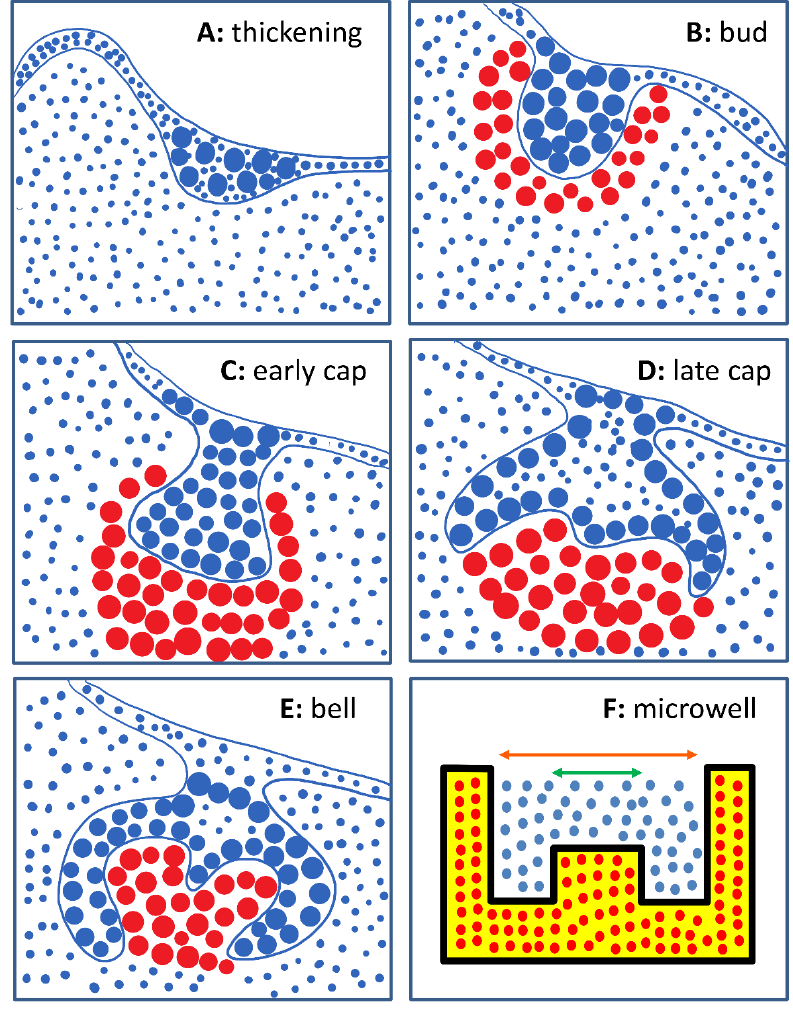
Figure 1. Human tooth development process and schematic representation of a tooth. ( A ) Thickening stage: Proliferation and thickening of oral epithelium; ( B ) Bud stage: Invagination of oral epithelium into mesenchyme and formation of tooth bud; ( C , D ) Cap stage: Condensation of mesenchyme around tooth bud, folding and formation of tooth germ; ( E ) Bell stage: Further folding to form tooth crown, differentiation into ameloblasts and odontoblasts. ( F ) Cross-sectional diagram of a single microwell. Yellow area represents methacrylated hyaluronic acid (MeHA) hydrogel structure, blue dots represent human adult low calcium high temperature (HaCaT) cells seeded in the microwell, and red dots represent dental pulp stem cells (DPSCs) encapsulated within the hydrogel. The orange and green arrows represent the outer diameter of the microwell and diameter of the central inlet, respectively.